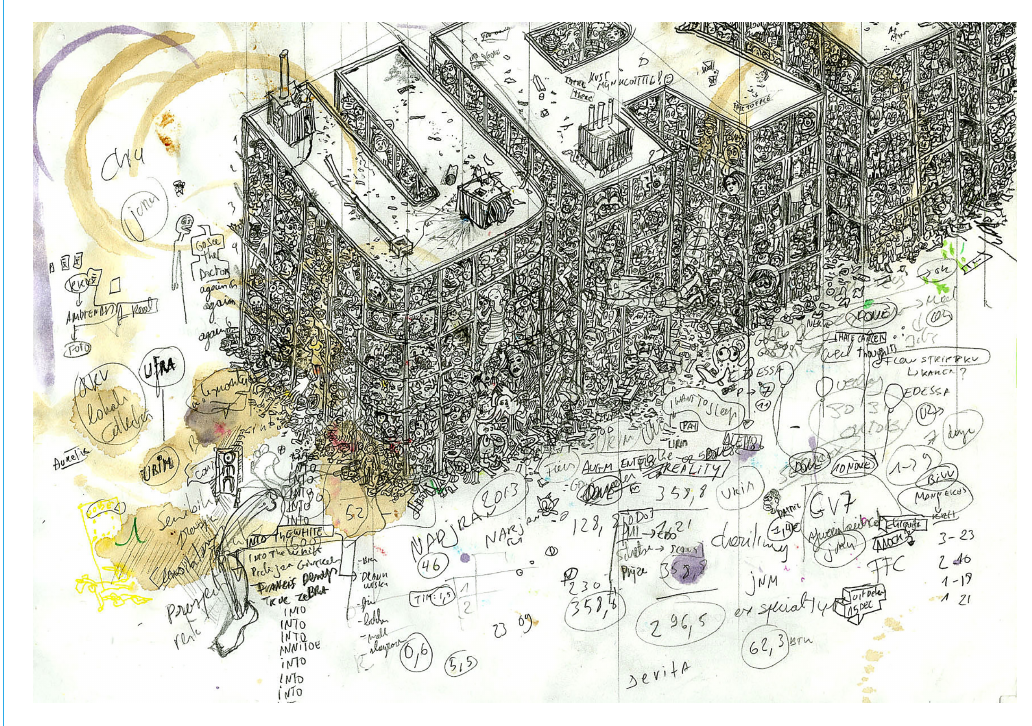
Figure 1: Stored memory (Andy has augmented